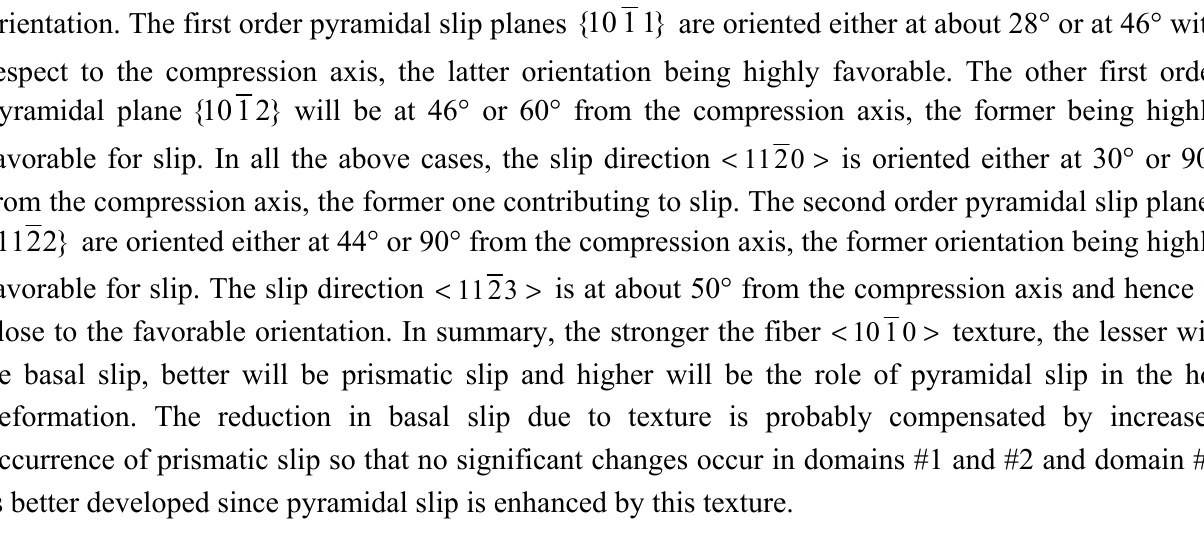
Figure 7. Arrhenius plot for calculating apparent activation energy in the three domains of processing map for AZ31 magnesium alloy extruded at 300